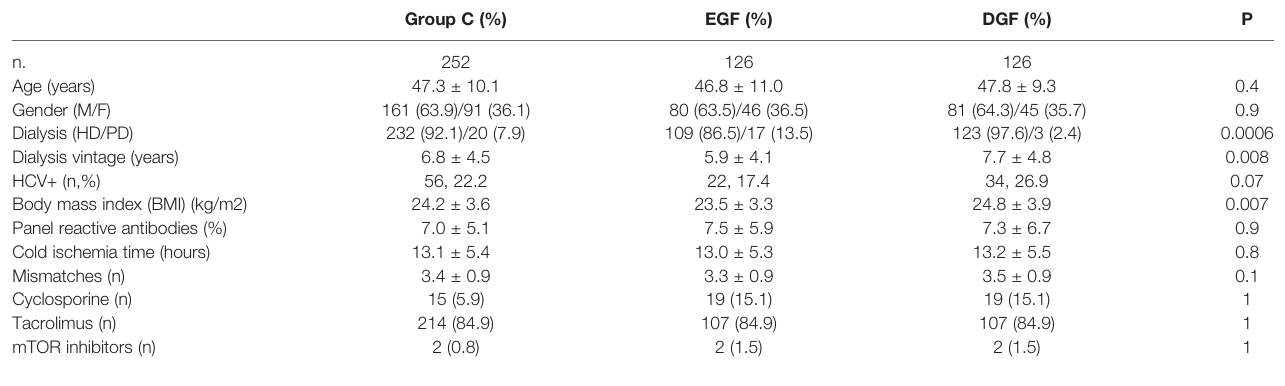
TABLE 5 | The main clinical and demographic features of Group C: EGF and DGF patients. Group C (%) EGF (%) DGF (%) P n.